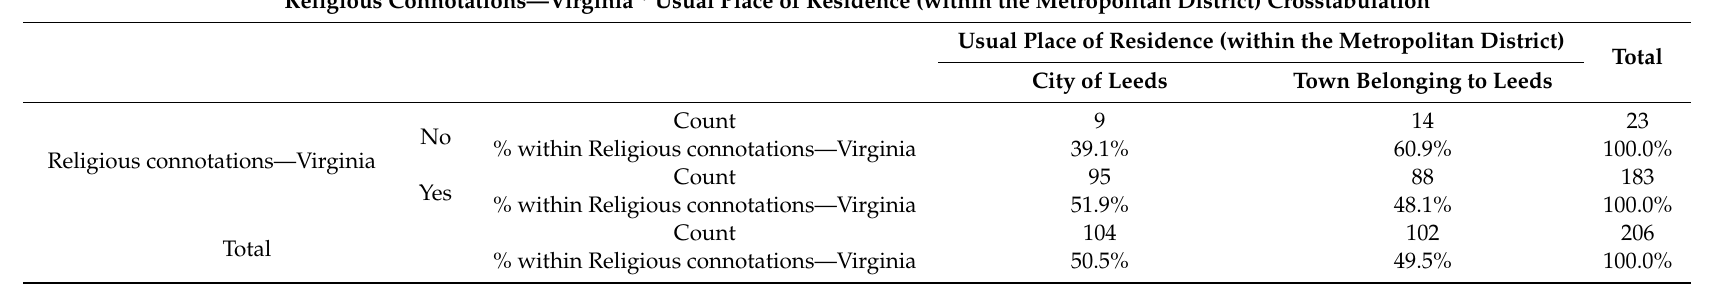
Table 12. Religious connotations in terms of usual place of residence for the name Virginia in the metropolitan district of Murcia. Religious Connotations—Virginia * Usual Place of Residence (within the Metropolitan District) Crosstabulation